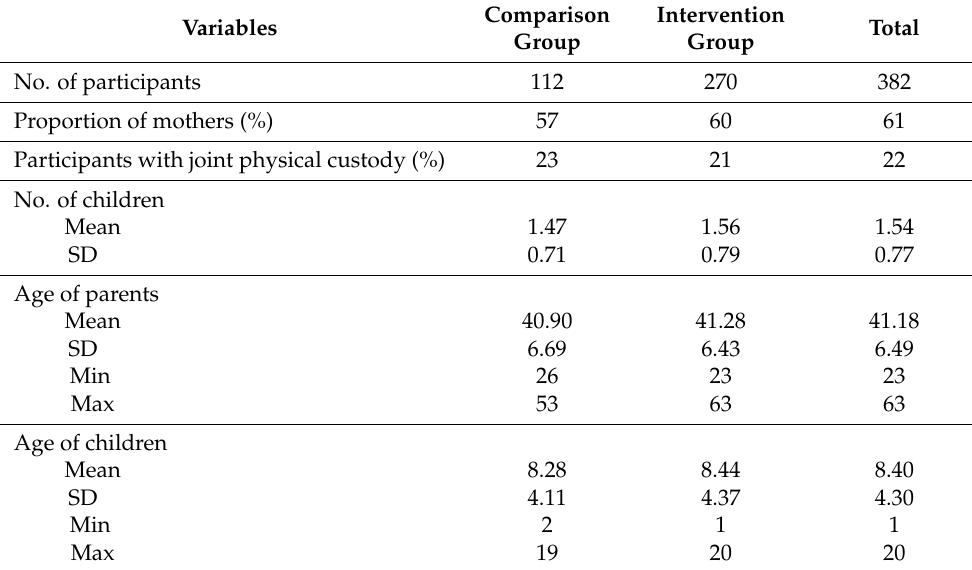
Table 1. Descriptive statistics by treatment group.